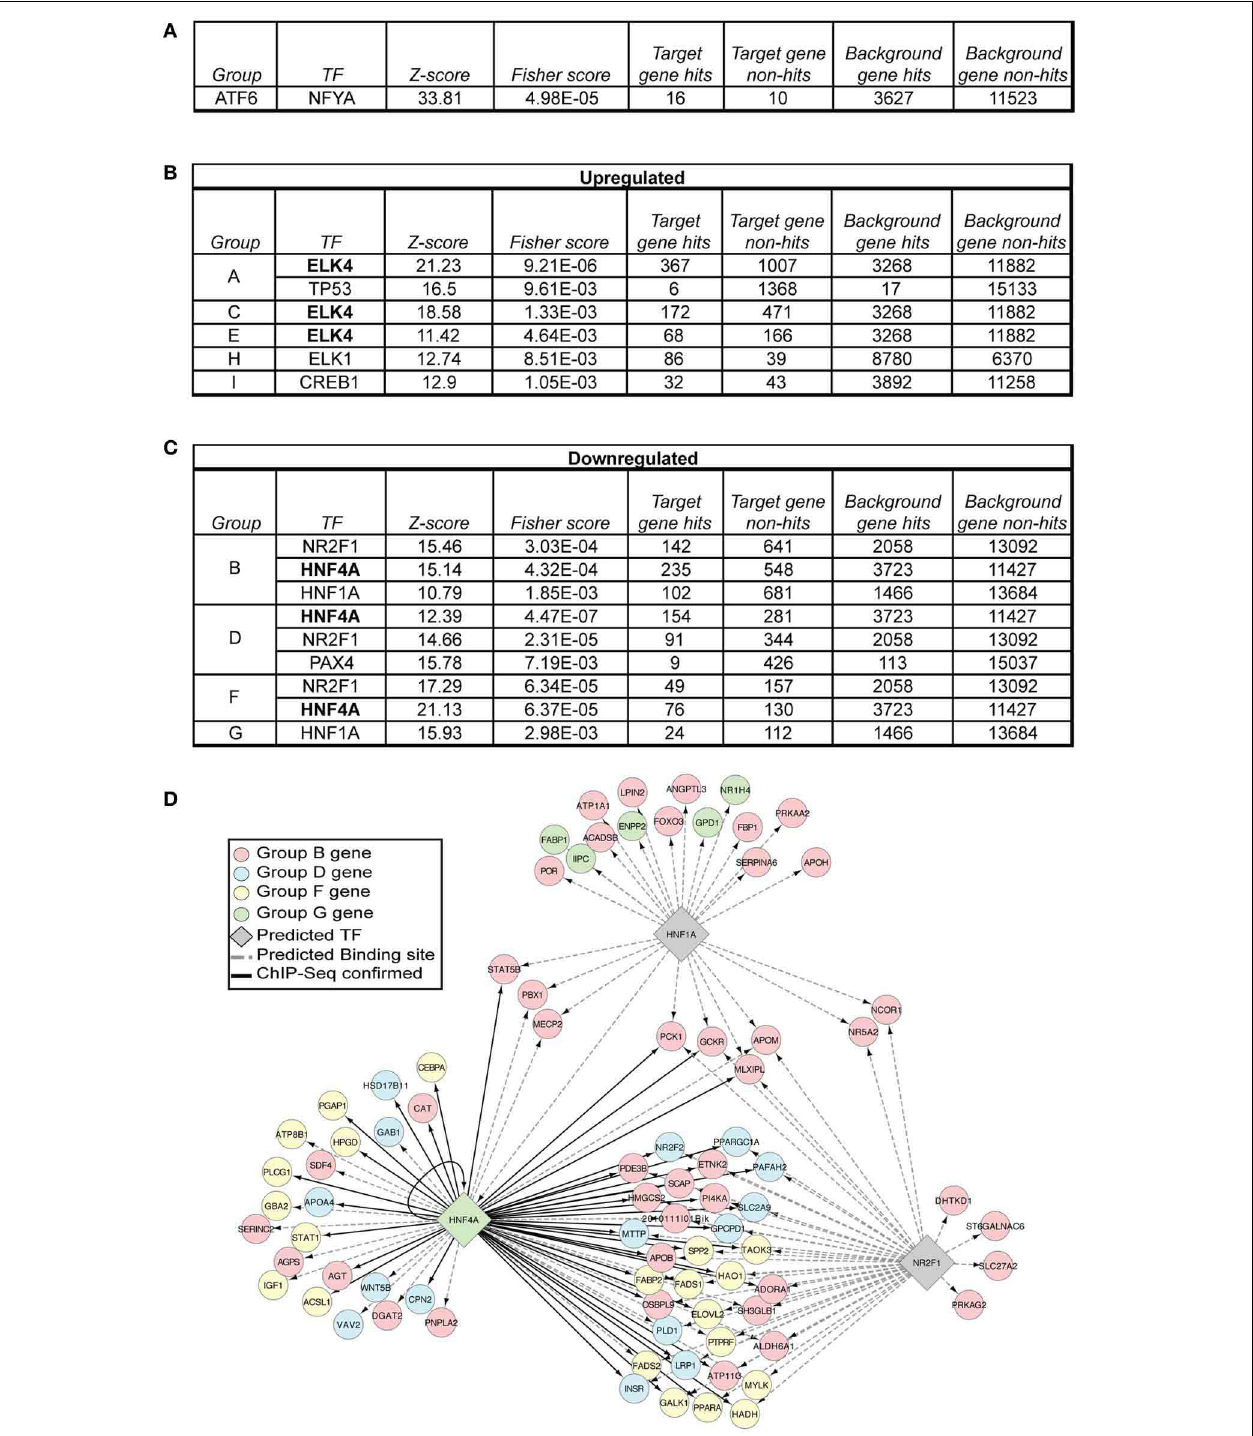
FIGURE 6 | Transcription factor prediction implicates ELK4, HNF1 α , NR2F1, and HNF4 α as hidden regulatory nodes in hepatic stress-dependent gene regulation. (A–C) Each of the gene groups in Figure 4 was subjected to oPOSSUM single-site analysis, which searches regulatory regions (in this case, ± 2000bp from the transcriptional start site) for potential binding sites of transcription factors identified in the JASPAR